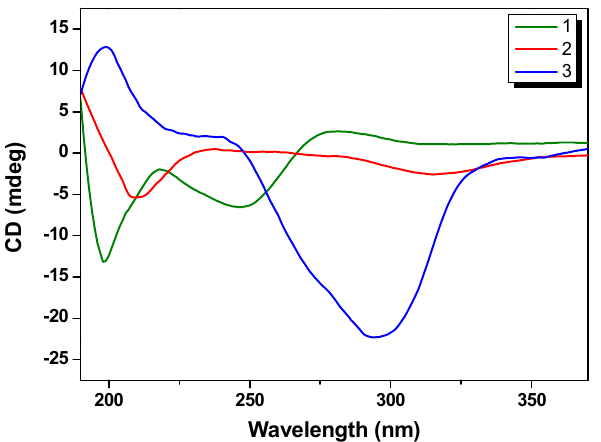
Figure 5. CD spectra of diluted aqueous solutions of compounds 1 , 2 , and 3 .